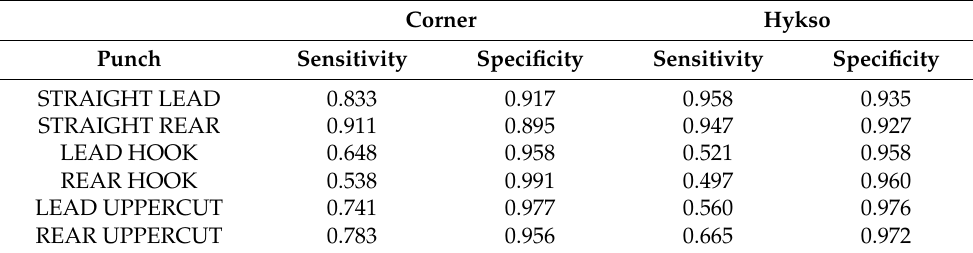
Table 6. Sensitivity and specificity of Corner and Hykso punch trackers to correctly recognize individual